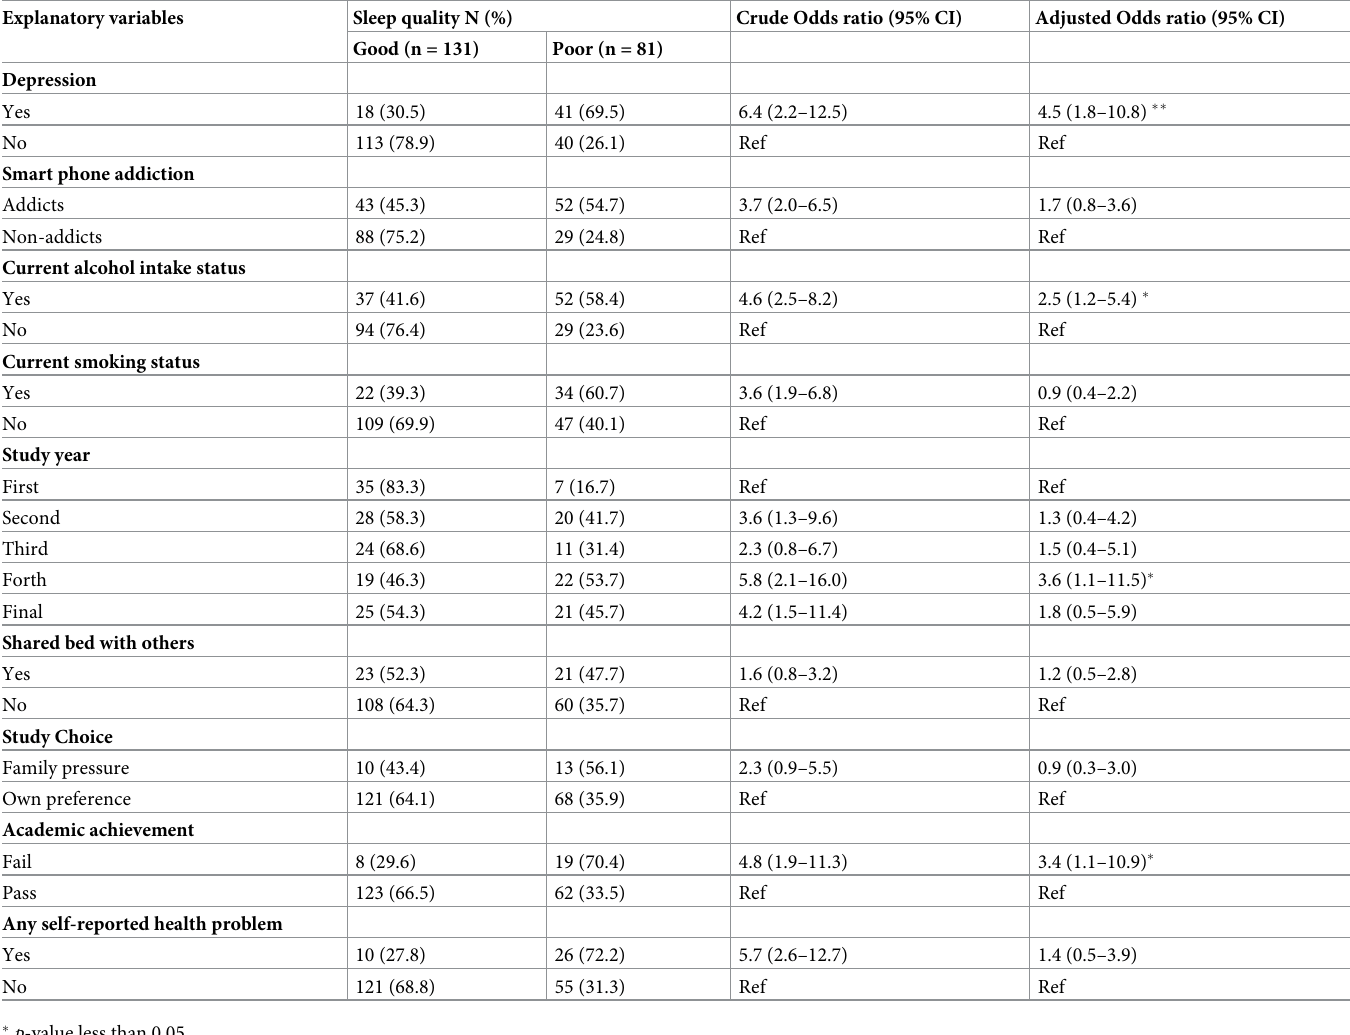
Table 4. Logistic regression analysis showing association between explanatory variables and sleep